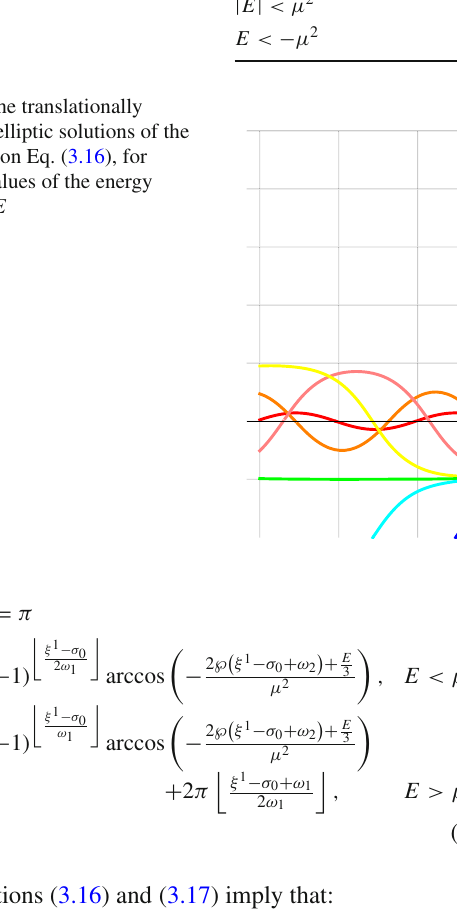
Table 2 The range of − μ 2 cos ϕ 0 for both real solutions of the Weierstrass equation